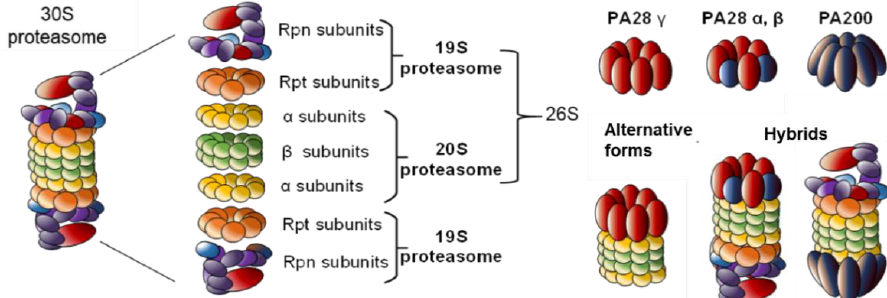
Figure 1. Proteasome complexity. The 26S proteasome is the most studied proteasome. However, alternative regulatory particles 19S, PA28 or PA200 are able to cap the core 20S proteasome to modulate its proteolytic activity. All these proteasome complexes (20S, 26S, 30S or hybrids) have been found in